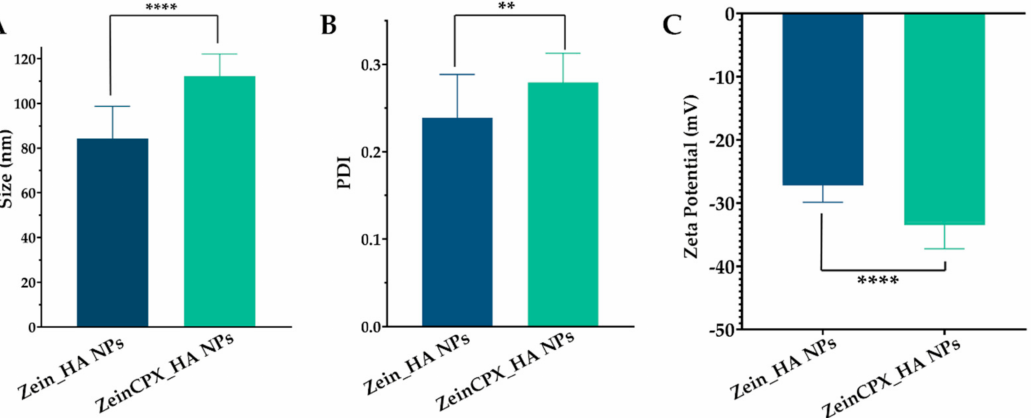
Figure 4. Evaluation of morphological properties of Zein_HA NPs and ZeinCPX_HA NPs: determi- nation of the hydrodynamic diameter values ( A ), PDI ( B ), and zeta potential ( C ). Data are presented as mean ± standard deviation, n = 5, ** < p = 0.01, **** p <